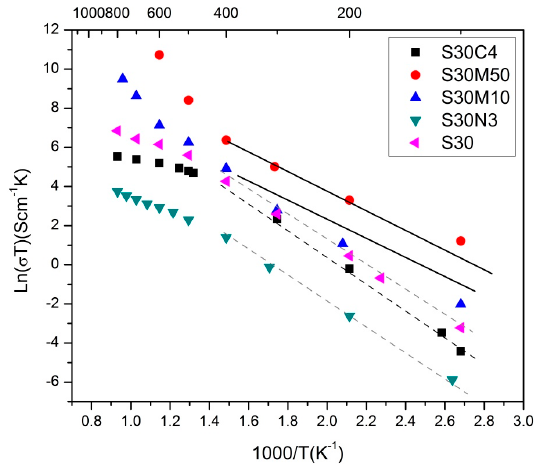
Figure 5. Arrhenius plot of electric conductivity of doped S30 as a function of the reverse of the testing temperature (1/ T ). The S30C4 results reported by Chen [27] are plotted in the diagram.